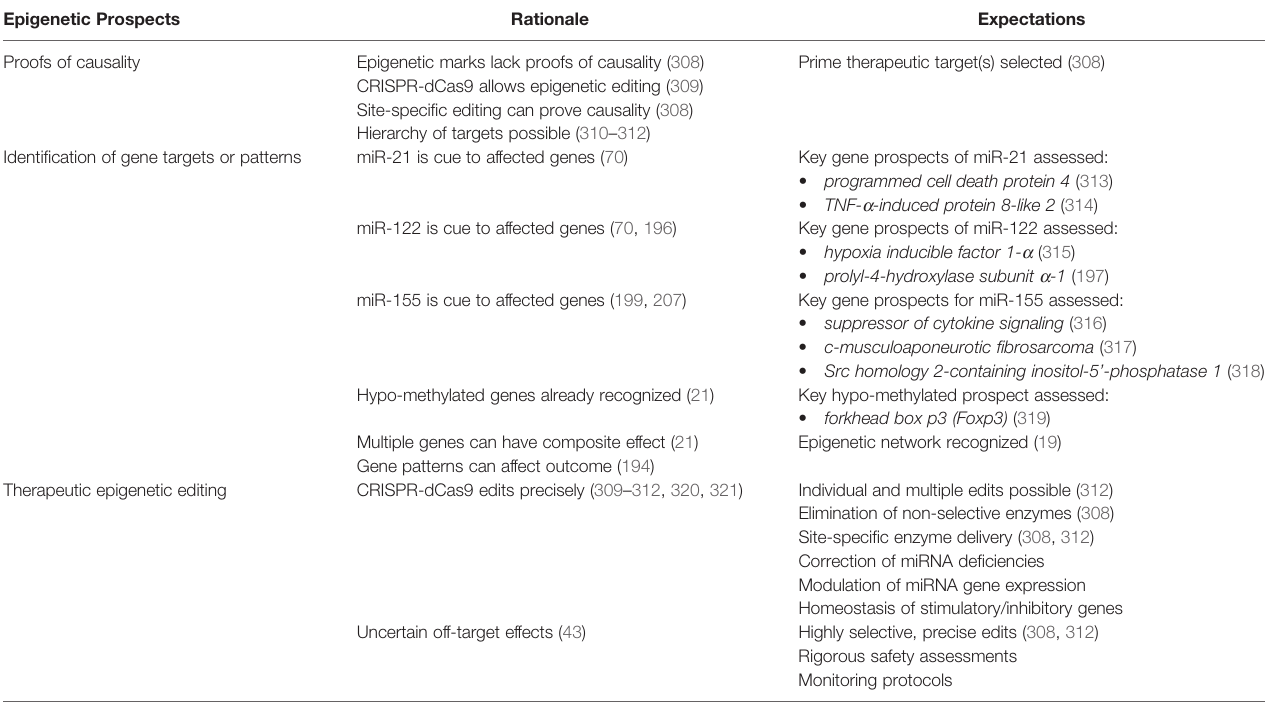
TABLE 6 | Epigenetic prospects in autoimmune